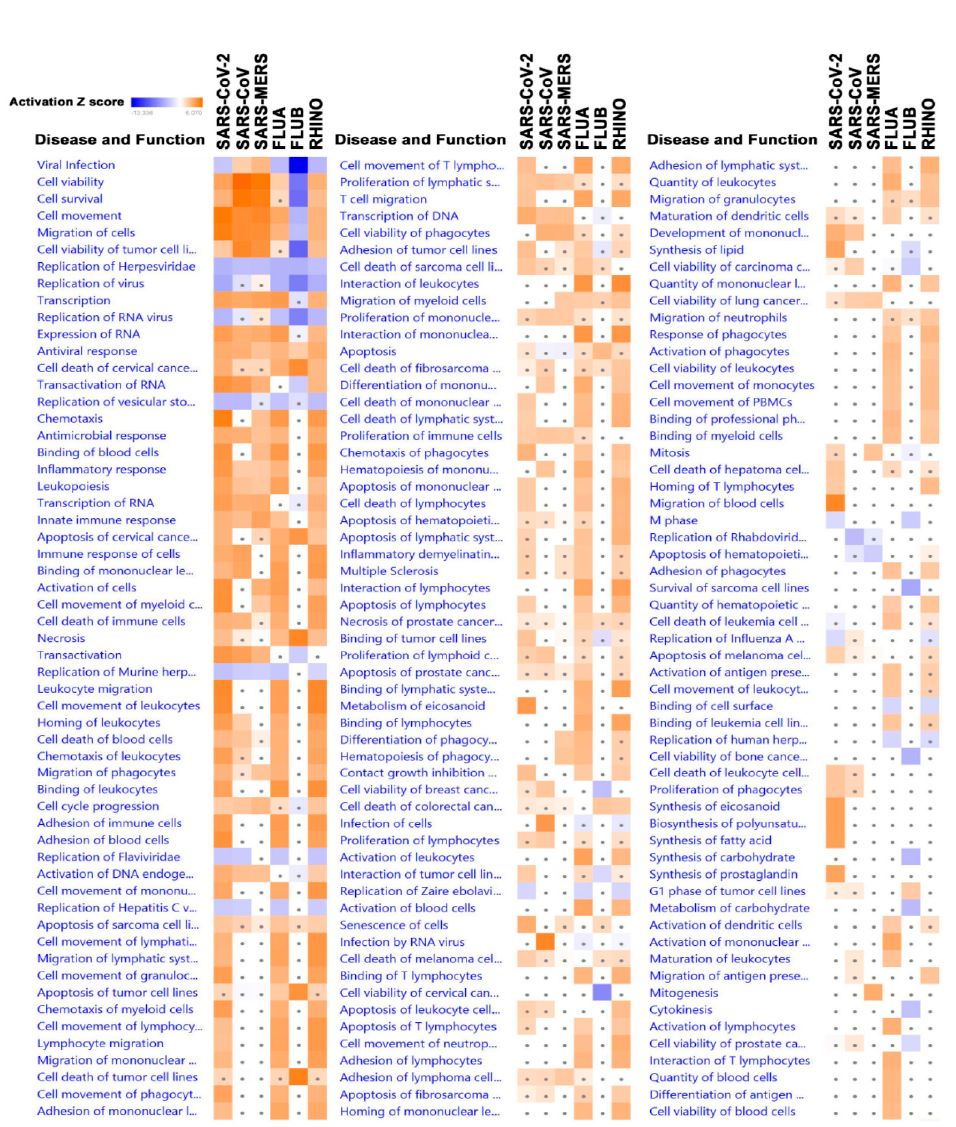
Figure 6. Significantly affected disease and function categories based on differentially expressed genes in the indicted treatment group (SARS-CoV-2, SARS-CoV, SARS-MERS, FLUA, FLUB, and RHINO) in Calu-3 cells. Differentially expressed genes from the six virally infected Calu-3 cells were subjected to disease and function analysis in IPA. Activation Z score is depicted according to the color scale (2.0 ≤ Z score ≤ − 2.0). Red indicates activation, while blue indicates suppression. Squares with a filled circle denote canonical with an activation Z score < 2.0.